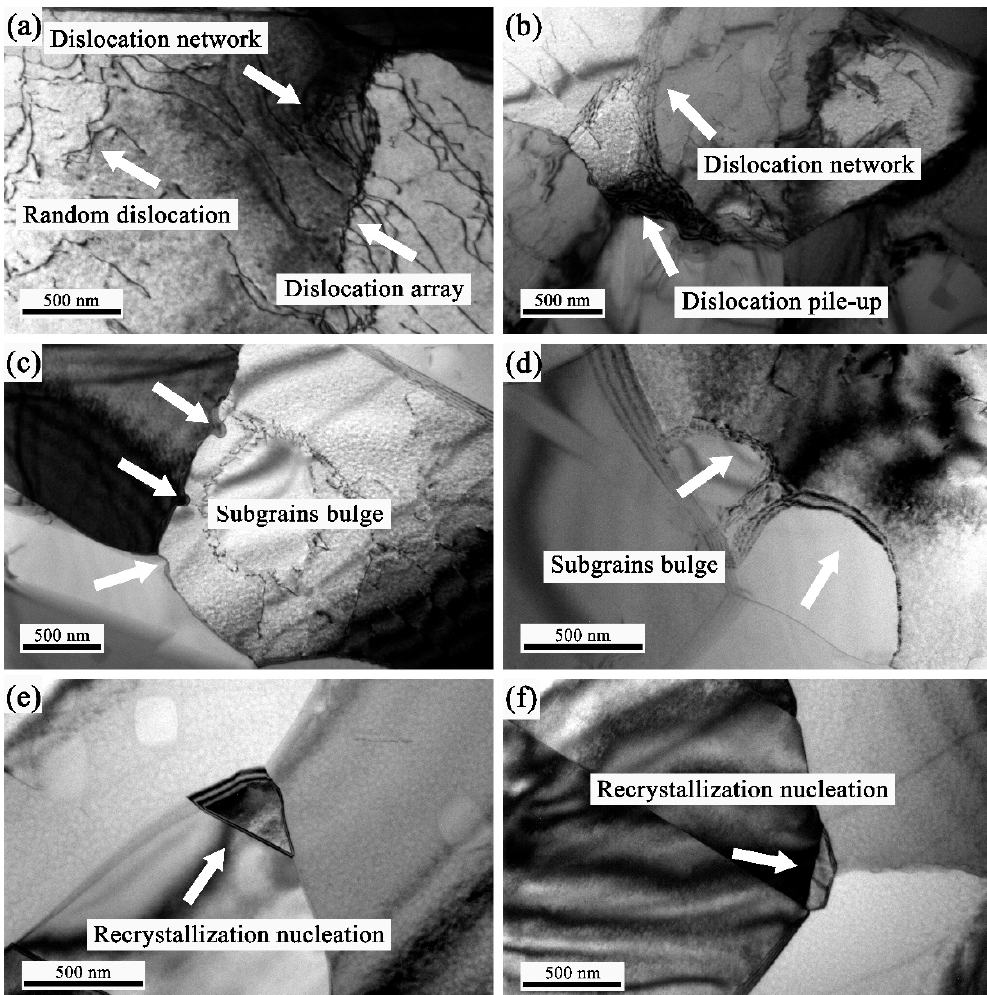
Figure 10. Typical TEM images of the alloy deformed to the ductility of 61.8% at 1080 °C with a strain rate of 1 × 10 − 3 s − 1 : ( a , b ) the morphology of dislocations, ( c , d ) subgrains bulge, ( e , f ) recrystallization nucleation.